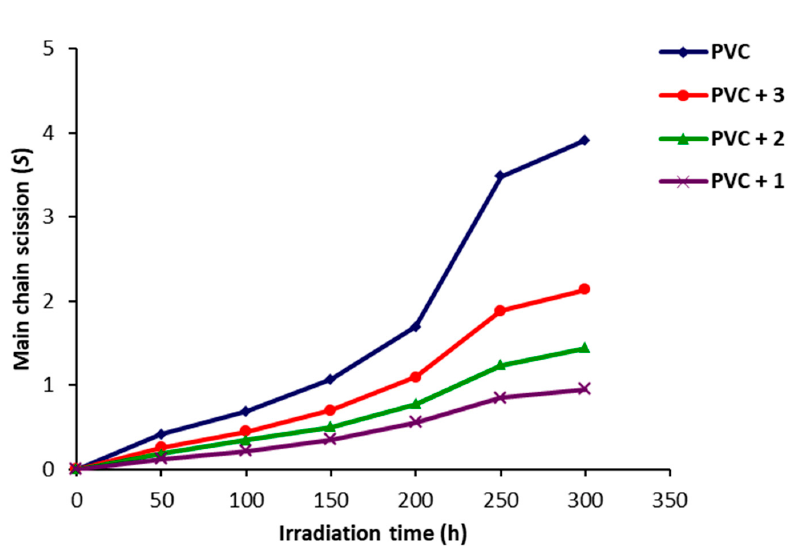
Figure 8. Effect of irradiation of PVC films on S .